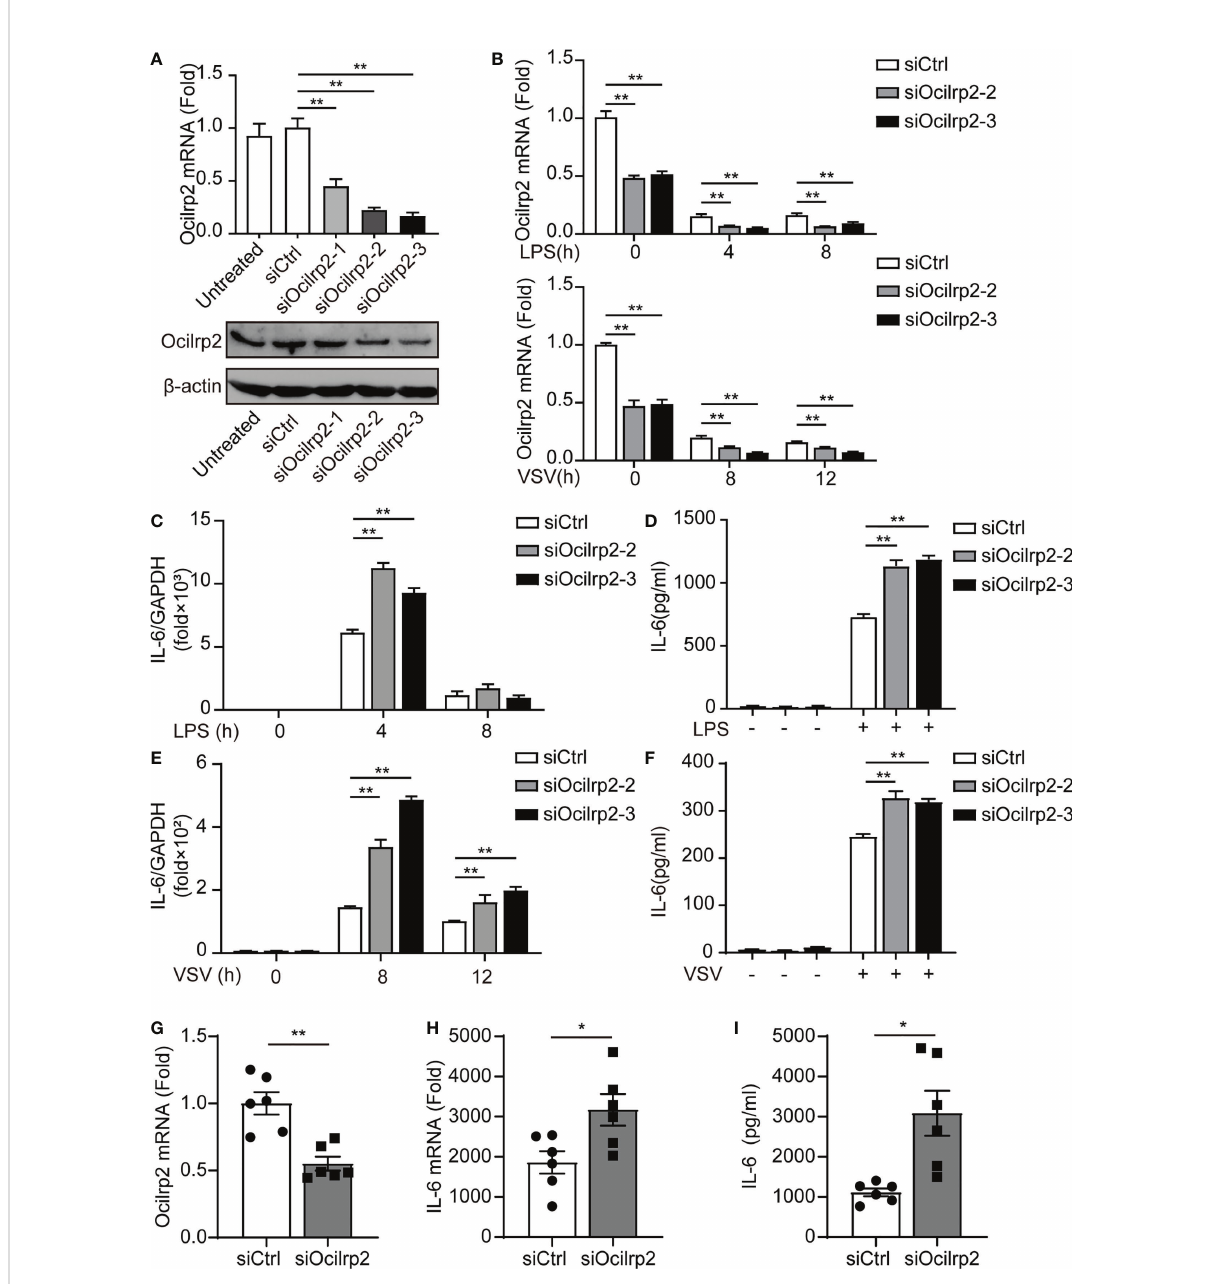
FIGURE 2 Silencing of Ocilrp2 promotes IL-6 expression in vitro and in vivo . (A) Peritoneal macrophages were transfected with scrambled siRNA (siCtrl) or three Ocilrp2 siRNAs (siOcilrp2-1, siOcilrp2-2, siOcilrp2-3) for 48 h, Ocilrp2 mRNA levels were detected with qRT-PCR, and Ocilrp2 protein levels were analyzed by Western Blot. The experiment was repeated three times. (B) qRT-PCR analysis of Ocilrp2 mRNA level in mouse peritoneal macrophages transfected with Ocilrp2 siRNA and 48 h later stimulated with LPS or infected with VSV for the indicated time. (C) qRT- PCR analysis of IL-6 mRNA level in macrophages transfected as in (A) , and 48 h later stimulated with LPS for the indicated time and (D) ELISA of IL-6 in supernatants of macrophages stimulated with LPS for 8 h. (E) qRT-PCR analysis of IL-6 mRNA level in macrophages transfected as in (A) , and 48 h later after VSV infection for the indicated time. (F) ELISA of IL-6 in supernatants of macrophages transfected as in (A) , and 48 h later infection with VSV for 8 h. (G, H) Six C57BL/6 mice were transfected in vivo with Ocilrp2 siRNA or Control siRNA (2.5 mg/kg) for 2 days, respectively. Then, peritoneal macrophages and serum were collected at 12 h after intraperitoneal injection of LPS (10 mg/kg). qRT-PCR analysis of Ocilrp2 and IL-6 mRNA level in mouse peritoneal macrophages and (I) ELISA of IL-6 in serum. Data were calculated from at least 3 independent experiments (means ± s.e.m.), * P < 0.05, ** P < 0.01 (The two-tailed Student ’ s